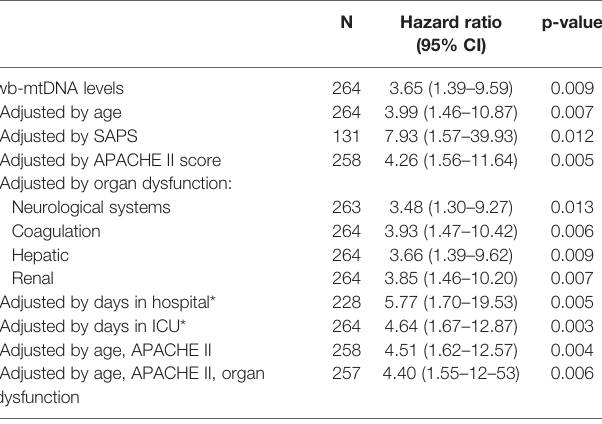
TABLE 3 | Demographic and clinical features of the ARDS patients. TABLE 4 | Association results of wb-mtDNA levels with 28-day survival in ARDS patients adjusting the models for the variables that were signi fi cantly different by mortality